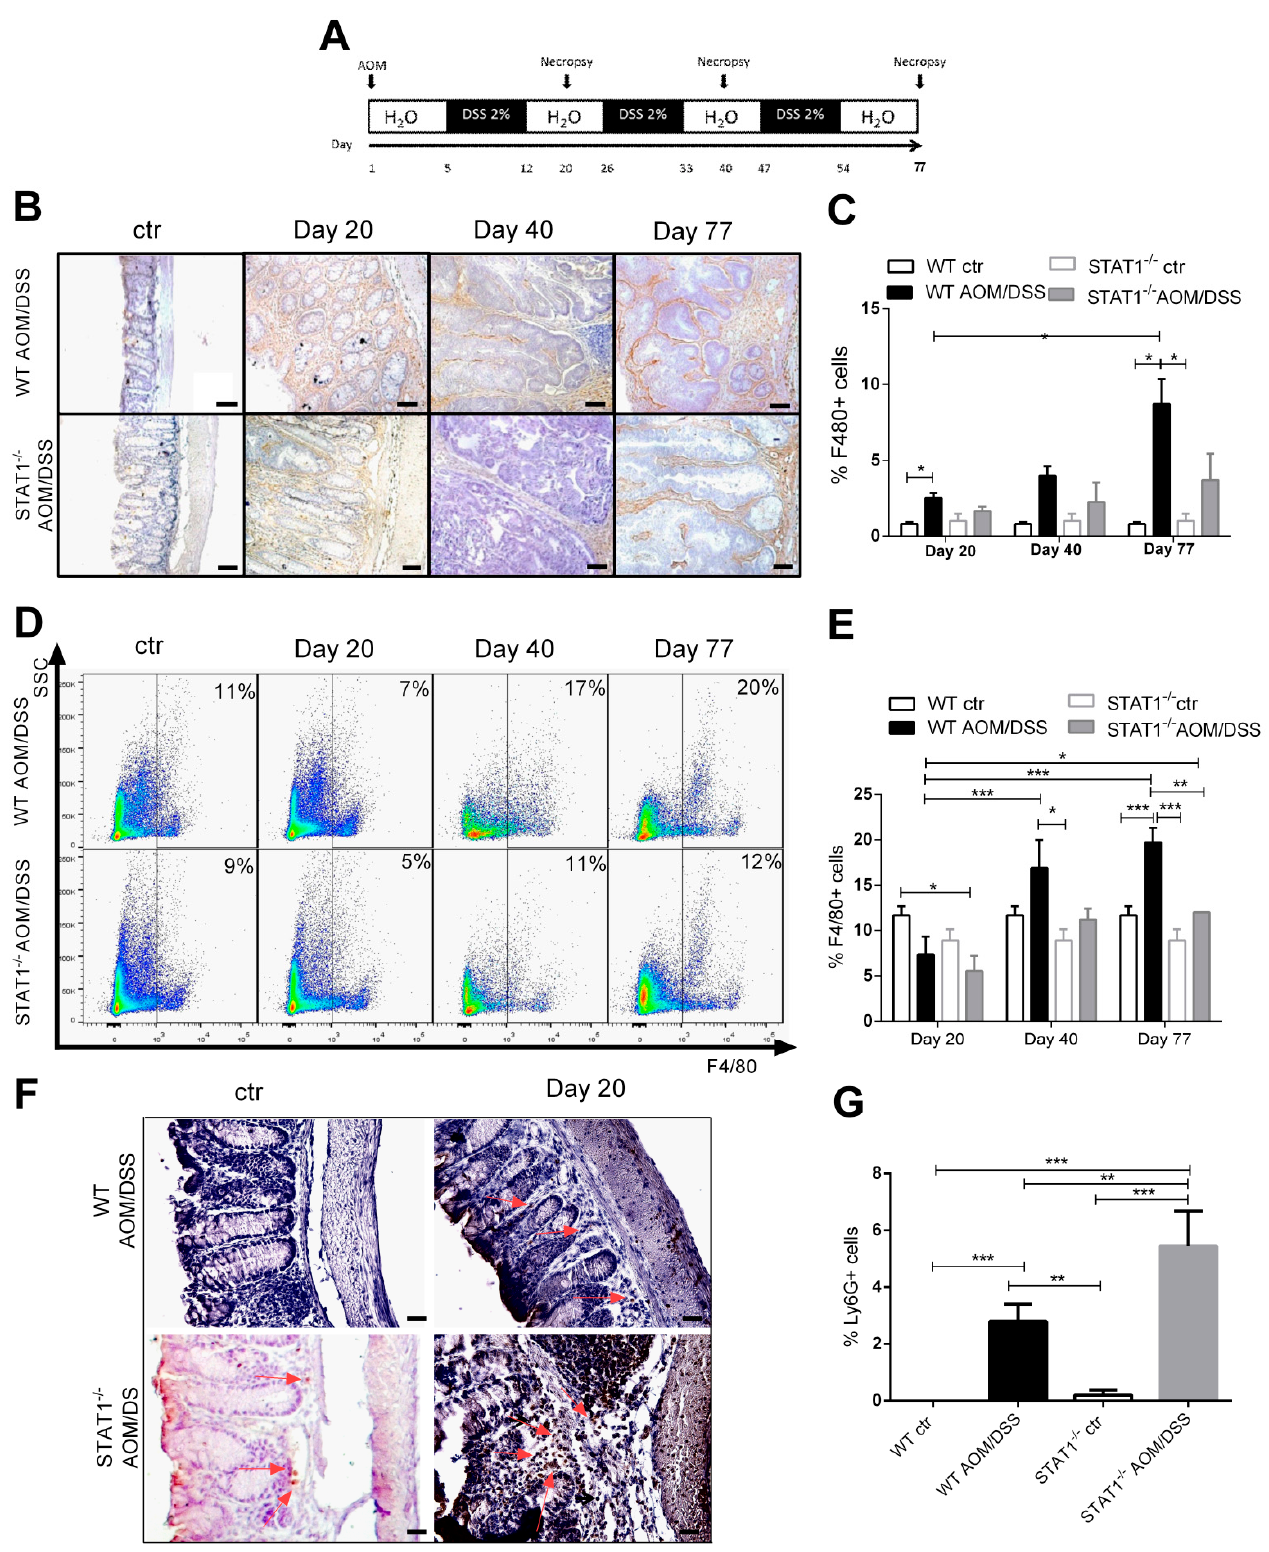
Figure 1. Macrophage populations are reduced in STAT1 -/- AOM/DSS-treated mice: ( A ) schematic time schedule of azoxymethane (AOM) and dextran sodium sulfate (DSS) administration. After the initial AOM injection (12.5 mg/kg), DSS was given in drinking water for 7 days followed by 14 days of regular drinking water. Mice were sacrificed on days 20, 40 (early tumor development), and 77 (late tumor development) post-AOM injection; ( B ) representative microscopic images showing immunohistochemical staining of F4/80 macrophages in colon tumor sections from WT and STAT1 -/- mice treated